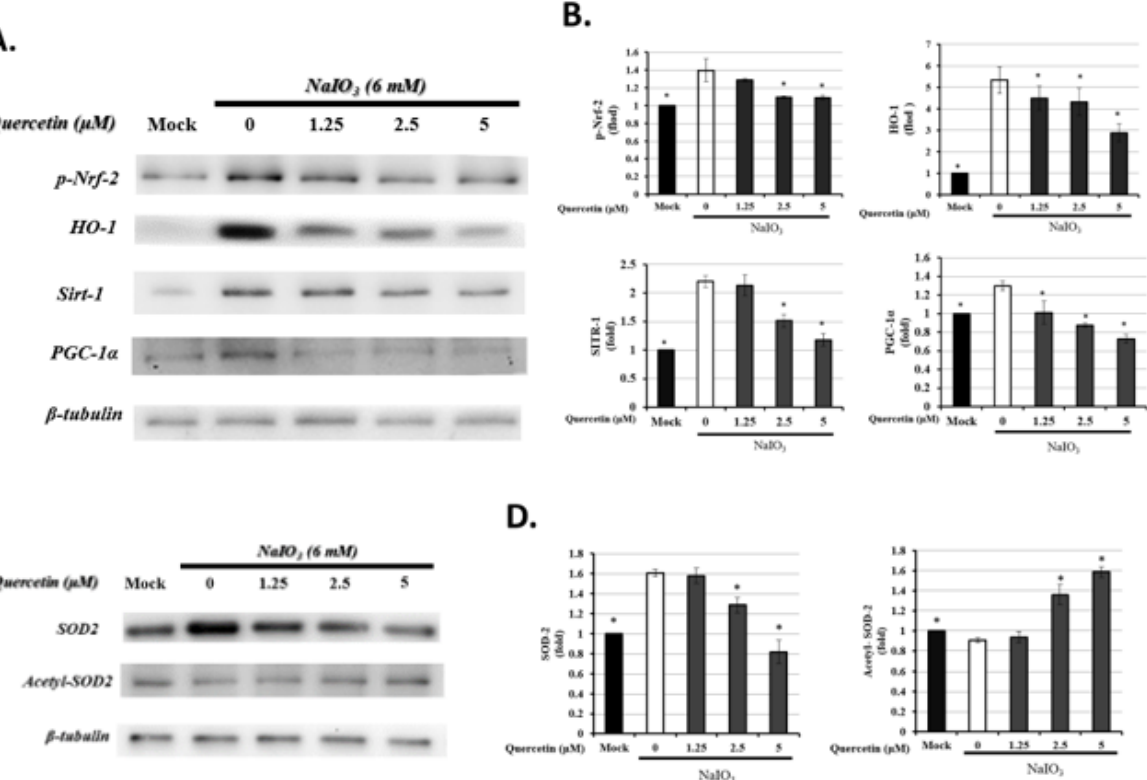
Figure 6. Quercetin reduced the expressions of mitochondrial proteins, including Nrf2, HO-1, Sirt1, and PGC-1 α , in NaIO 3 - treated ARPE19 cells. ARPE-19 cells were either untreated (mock) or treated with 0, 1.25, 2.5, or 5 μM quercetin followed by NaIO 3 (6 mM). Total protein from the ARPE-19 cells was extracted for the measurement of Nrf2, HO-1, SOD-2, acetyl- SOD-2, Sirt1, and PGC- 1α expressions using Western bl ot analysis. ( A , C ) Representative photographs of Western blotting products are shown. The quantified expressions of ( B ) Nrf2, HO-1, SOD2, and acetyl-SOD2, as well as ( D ) Sirt1 and PGC- 1α , as mean ± SD ( n = 3, 3 individual set experiments of groups). Data w ere normalized to β -tubulin. * p - values ≤0.05 were considered statistically significant.